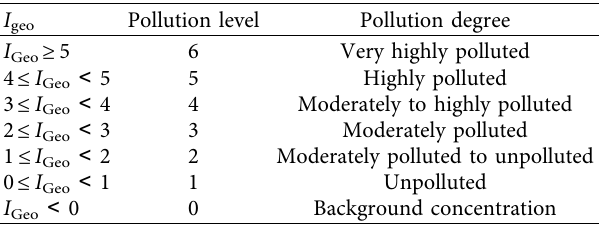
Figure 1: Location of the study area and sampling sites. Table 1: Geoaccumulation index